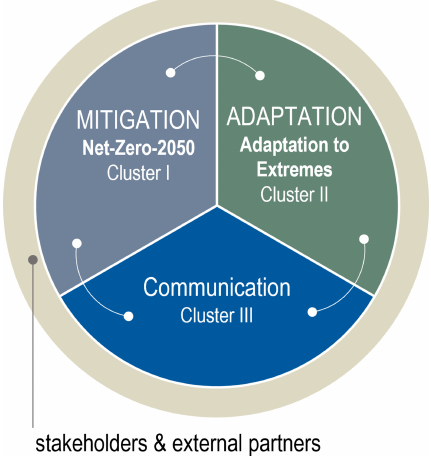
Figure 1. The three clusters of the Helmholtz Climate Initiative are closely collaborating. All of the three clusters seek active communi- cation with stakeholders and external partners to transfer knowledge to non-scientific